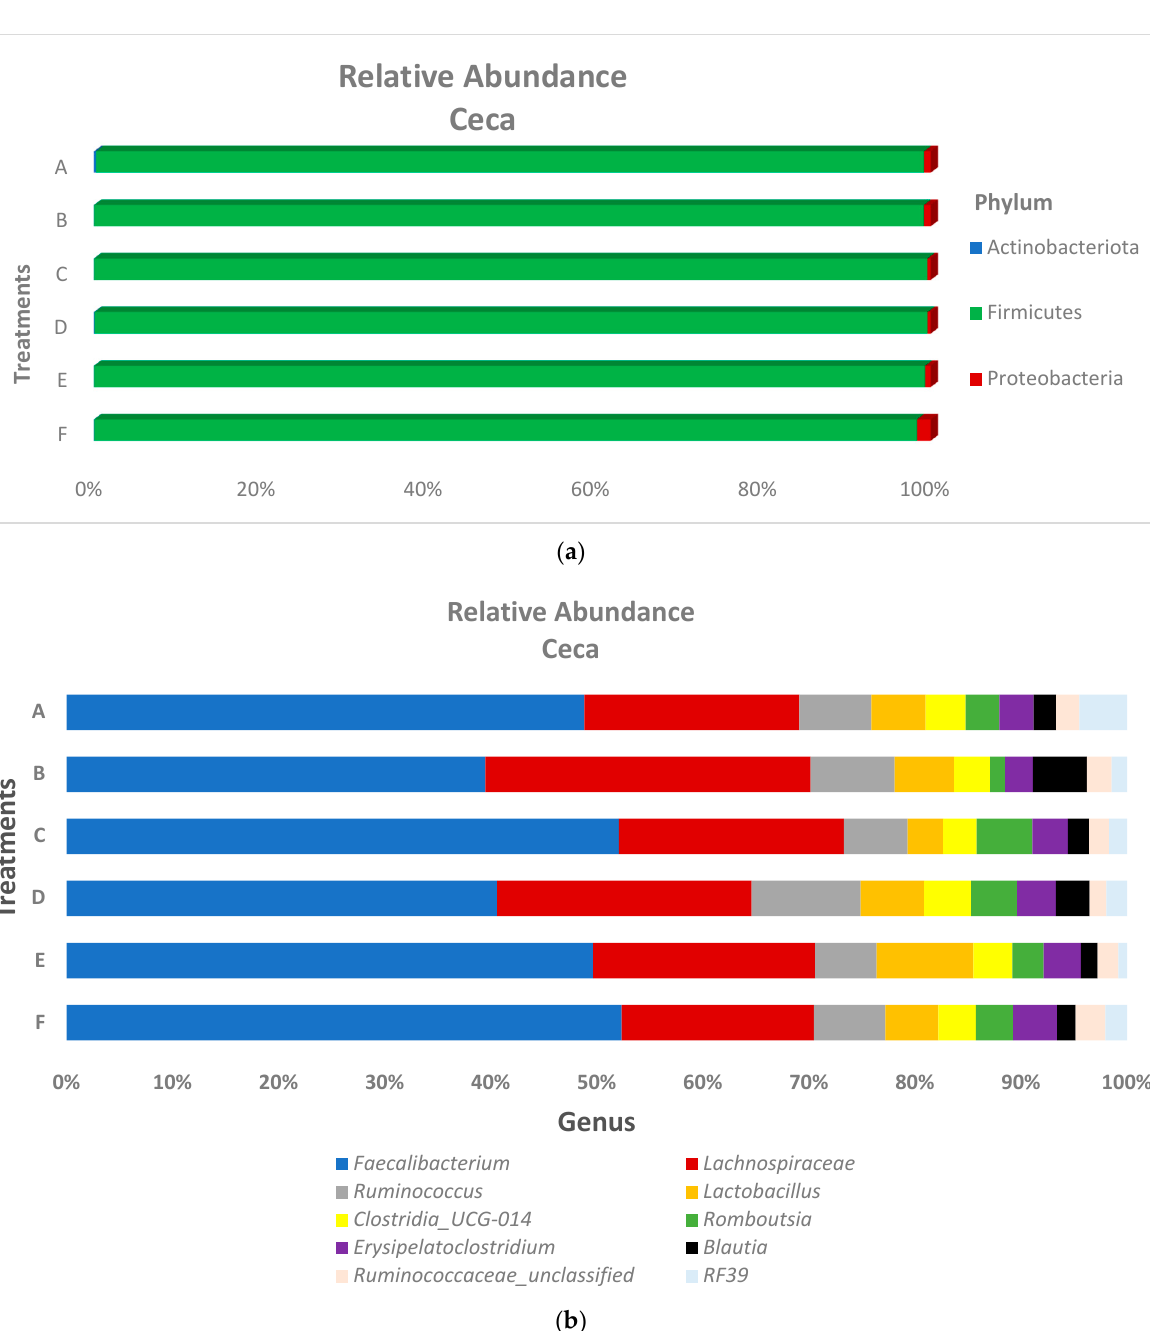
and in water route,